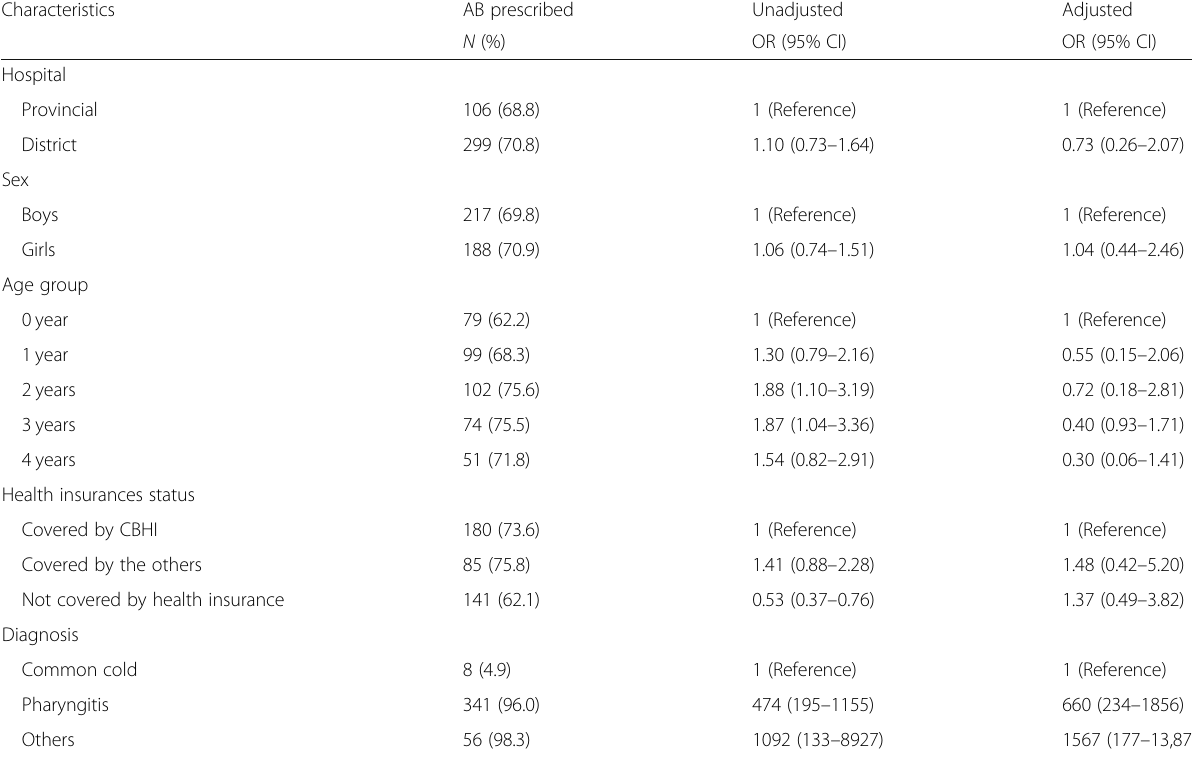
Table 7 Odds ratios (ORs) and 95% confidence intervals (CIs) of antibiotic prescription for outpatients under 5 years of age with common cold or upper respiratory tract infection